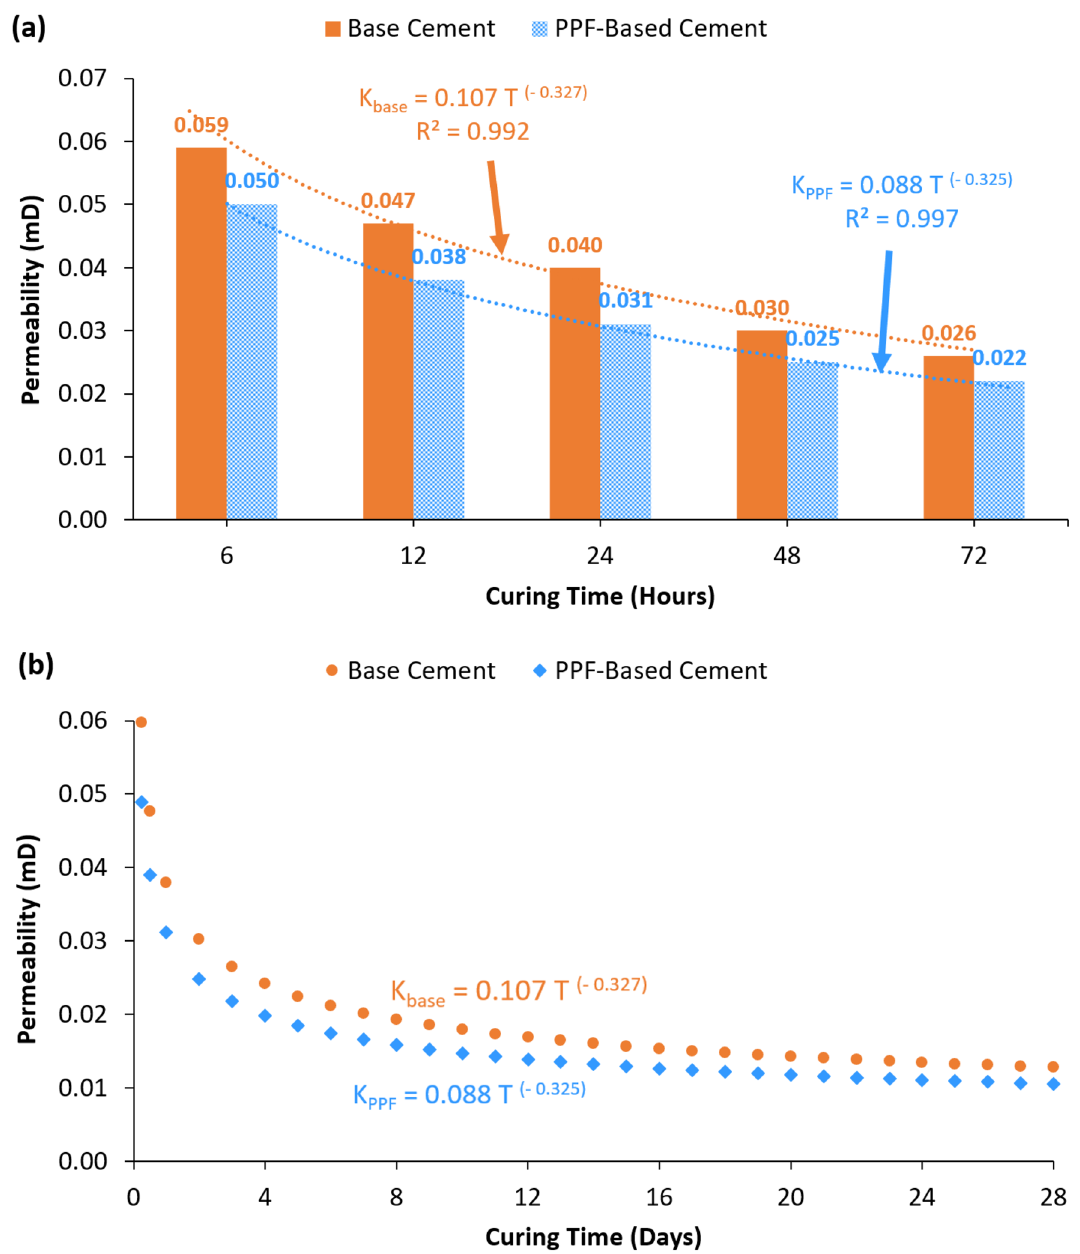
Fig. 6 Permeability for polypropylene and base specimens at various stages of curing. a The findings of the permeability during the early curing times. b The anticipated variations in permeability over 4